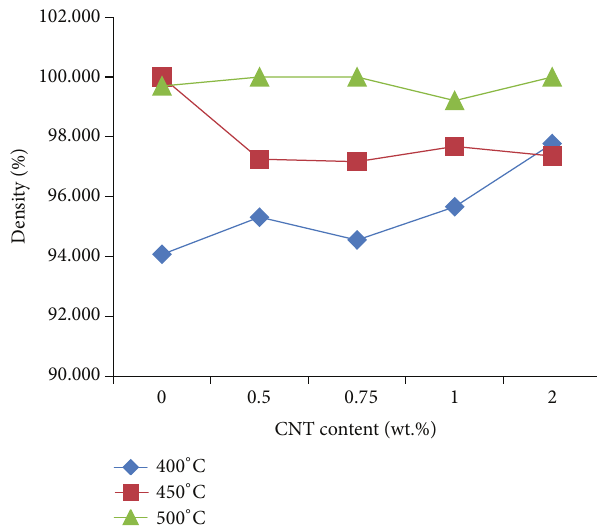
Figure 7: Relative density of CNT reinforced Al6061 nanocompos- ites.